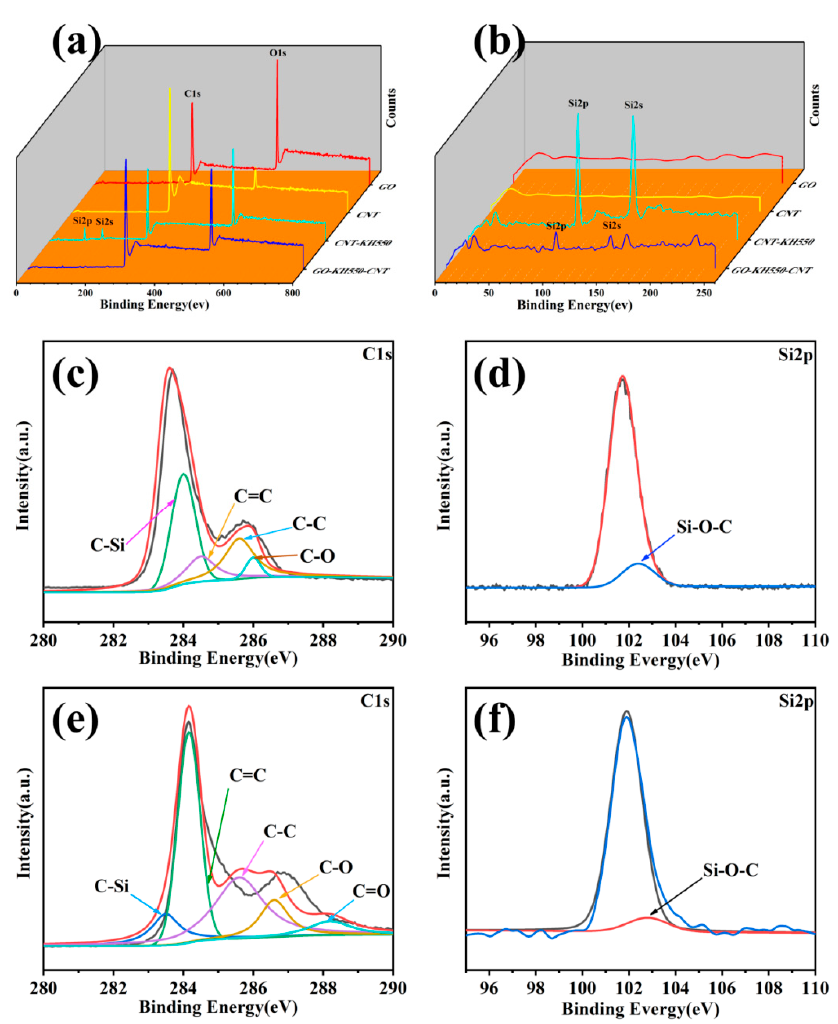
Figure 6. XPS spectra of GO, CNT, CNT-KH550 and CNT-GO, ( a ) and ( b ) XPS wide spectrum, ( c ) C1s spectrum of CNT-KH550, ( d ) Si2p spectrum of CNT-KH550, ( e ) C1s spectrum of GO-CNT, ( f ) Si2p spectrum of GO-CNT. (color figure can be viewed on line).